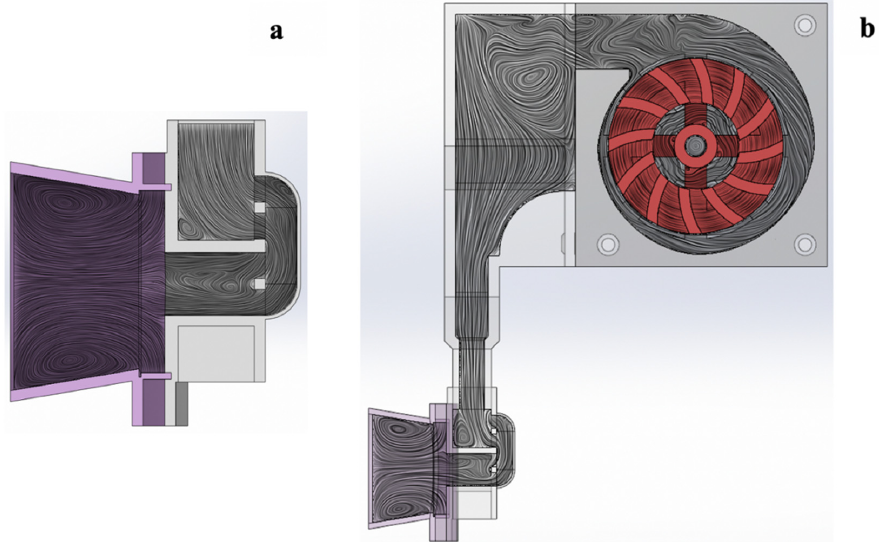
Figure 9. Airflow streamlines in the ( a ) Accuhaler alone, and ( b ) Accuhaler attached with add-on equipment as determined by CFD simulation.